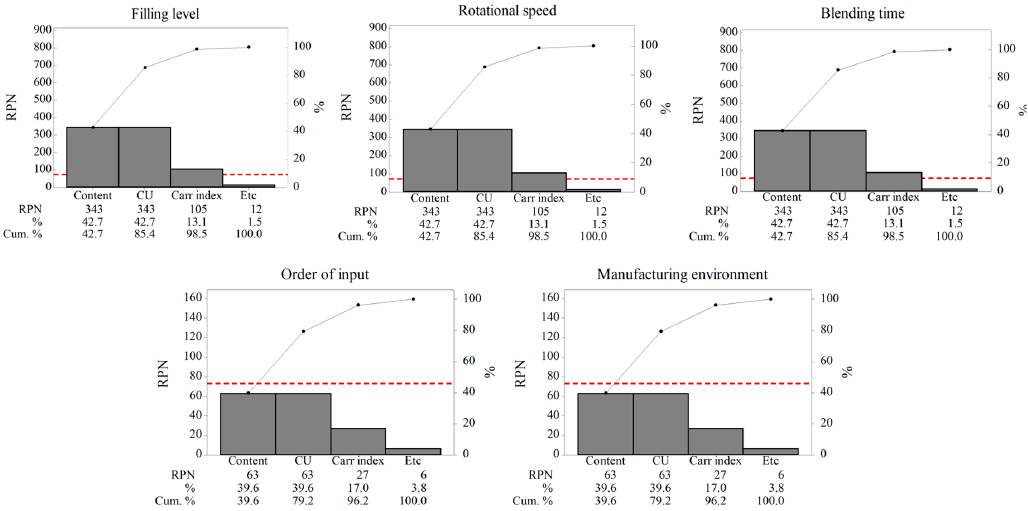
Figure 2. RPN-score-based Pareto chart for each process parameter in the blending process. The red dotted line denotes the threshold value (72.9) and Cum. represents percentage cumulative RPN.